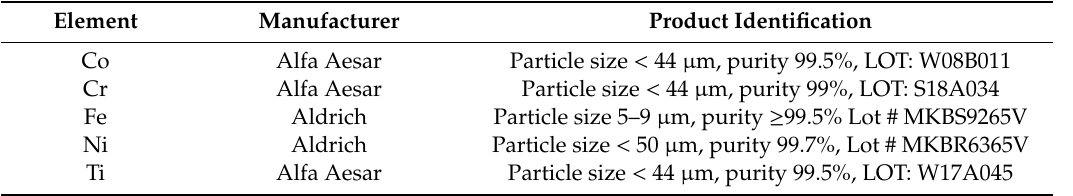
Table 1. Manufacturers and product identification of used